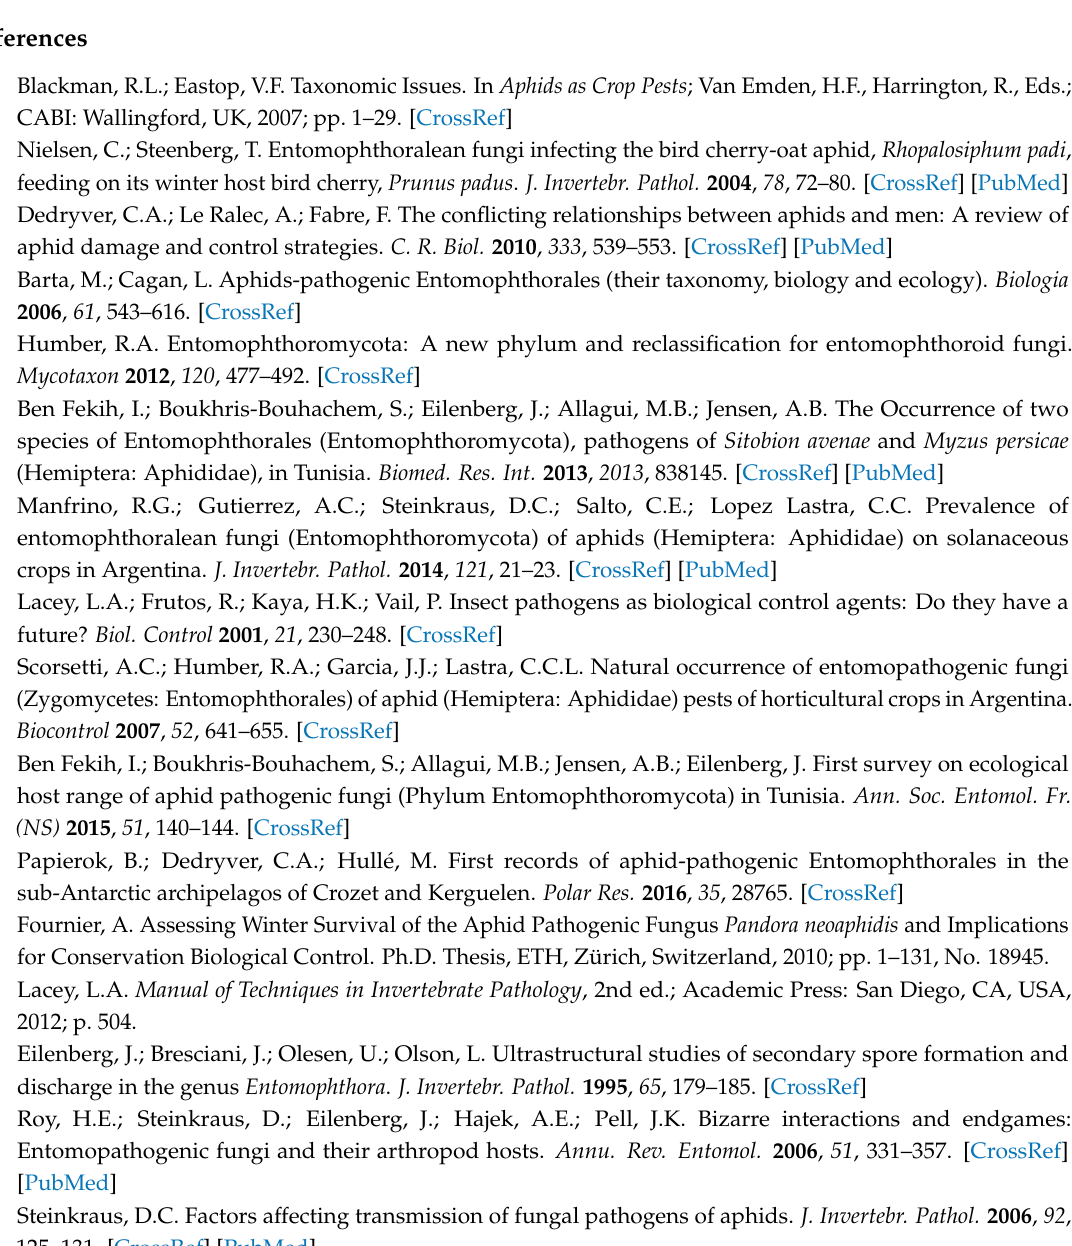
Table S1: Aphid-mortality records over time (hours), after the two fungal treatments, for each aphid species. Replicates, number of incubated aphids, total numbers of dead aphids are presented. Total numbers of dead aphids, is split to deaths caused by fungus and those did not show any fungal infection symptom, and therefore, the cause of death could not be determined. Script S1: R code for analyzing the data including statistical tests and